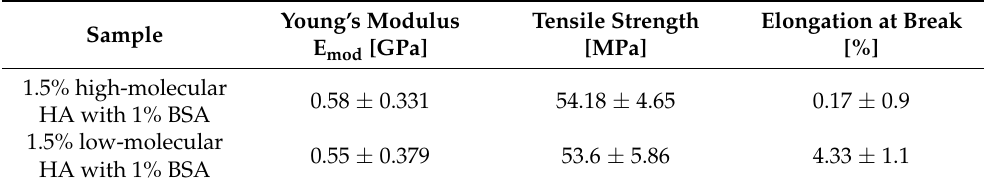
Table 5. Mechanical properties of films made from a mixture of hyaluronic acid solution with bovine serum albumin.